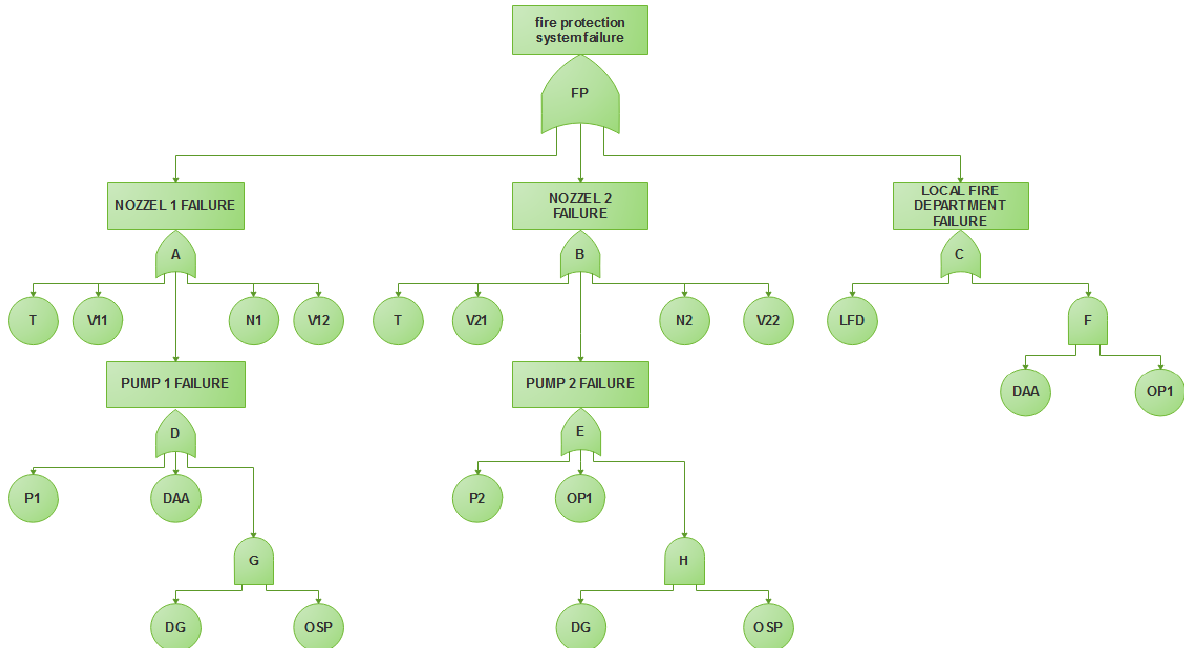
Figure 5. Automatic fire sprinkler system fault